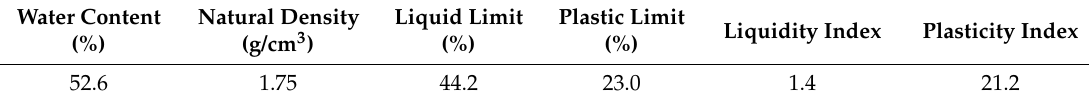
Figure 2. Particle size distribution of soils used in the tests. Table 1. Properties of the test silty clay.